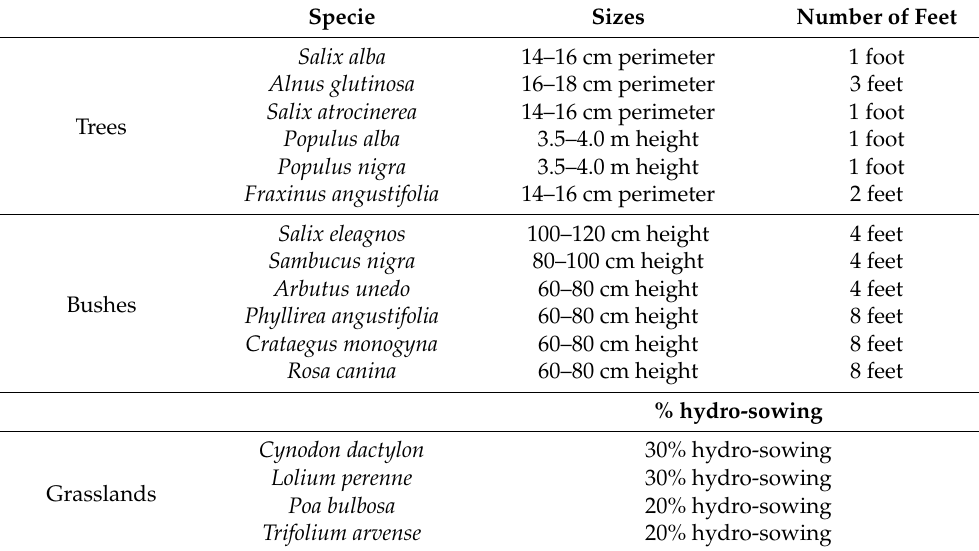
Table 8. Species to be planted on the subfield watercourses and subfield